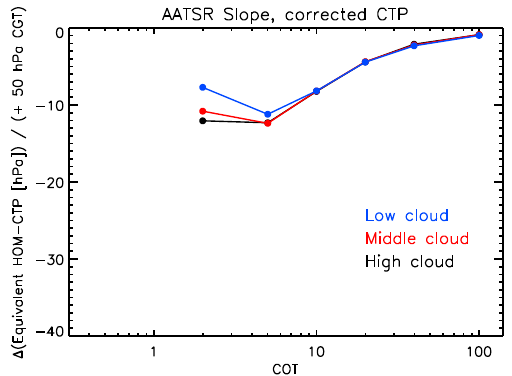
Figure 4. The sensitivity of the equivalent AATSR HOM CTP to an increase of CGT by 50hPa. The pressure at 1 COT into the cloud is taken as corrected CTP. Cloud-top pressure of low cloud = 800hPa, middle cloud = 600hPa, and high cloud =